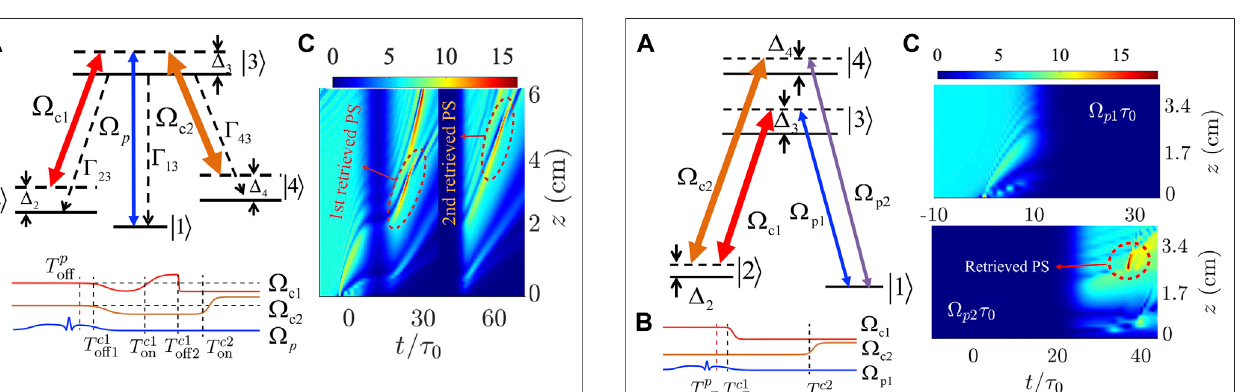
FIGURE 4 | Splitting of optical Peregrine solitons. (A) Energy-level diagram and excitation scheme of the tripod-type four-level atomic system. FIGURE 5 | Routing of optical Peregrine solitons. (A) The energy-level Here,aprobelaser fi eld Ω p drives the transition | 1 〉 ↔ | 3 〉 ; thetwo CW control diagram and excitation scheme of the double- Λ -type four-level atomic fi elds Ω Ω | 2 〉 ↔ | 3 〉 and | 4 〉 ↔ | 3 〉 , c 1 and c 2 drive the transitions system. In this con fi guration, two probe laser fi elds Ω p 1 and Ω p 2 drive the respectively; Γ j 3 is the decay rate from | 3 〉 to | j 〉 ( j (cid:2) 1 , 2 , 4); Δ 3 and Δ l ( l (cid:2) 2 , 4) transitions | 1 〉 ↔ | 3 〉 and | 1 〉 ↔ | 4 〉 , respectively; two CW control laser are respectively one-photon and two-photon detunings. (B) Time sequences fi elds Ω Ω | 2 〉 ↔ | 3 〉 and | 2 〉 ↔ | 4 〉 , respectively; Δ of the control and the probe fi elds for realizing the optical splitting. The vertical c 1 and c 2 drivethe transitions 3 and Δ 4 are one-photon detunings, and Δ 2 is two-photon detuning. (B) Time red dashed line is for t (cid:2) T p off ; the vertical black dashed lines represent the sequences of the two control fi elds Ω c 1 , Ω c 2 and the probe fi eld Ω p 1 for times when switching off and on the two control fi elds. For detailed meanings realizing the soliton routing. The vertical red dashed line denotes the time of the symbols T c 1 off1 , etc., see text. (C) The contour map of the splitting t (cid:2) T p off ; the vertical black dashed lines denote the times when switching off process of the Peregrine soliton in the t - z plane. The intensities of two split (cid:4)(cid:4)(cid:4)(cid:4) (cid:4)(cid:4)(cid:4)(cid:4) and on the control fi elds. (C) Contour maps for the routing process of the τ (cid:2) 15 . 4 when t (cid:2) 23 . 0 τ (cid:2) Ω Peregrine solitons are p 0 0 at the position z max Peregrine soliton, where the upper panel is for Ω p 1 and the lower panel is for 3 . 7cm ( fi rst retrieved Peregrine soliton, i.e., “ 1st retrieved PS ” indicated in the (cid:4)(cid:4)(cid:4)(cid:4) (cid:4)(cid:4)(cid:4)(cid:4) Ω fi eld Ω fi gure) and τ (cid:2) 14 . 0 when t (cid:2) 61 . 5 τ (cid:2) 5 . 5cm Ω p 2 . The Peregrine soliton is input as the probe p 1 , but it is retrieved as p 0 0 at the position z max theprobe fi eld Ω p 2 (i.e., “ retrievedPS ” indicatedbythereddashedcircleinthe (second retrieved Peregrine soliton, i.e., “ 2nd retrieved PS ” indicated in the lower panel of the fi gure). fi gure),